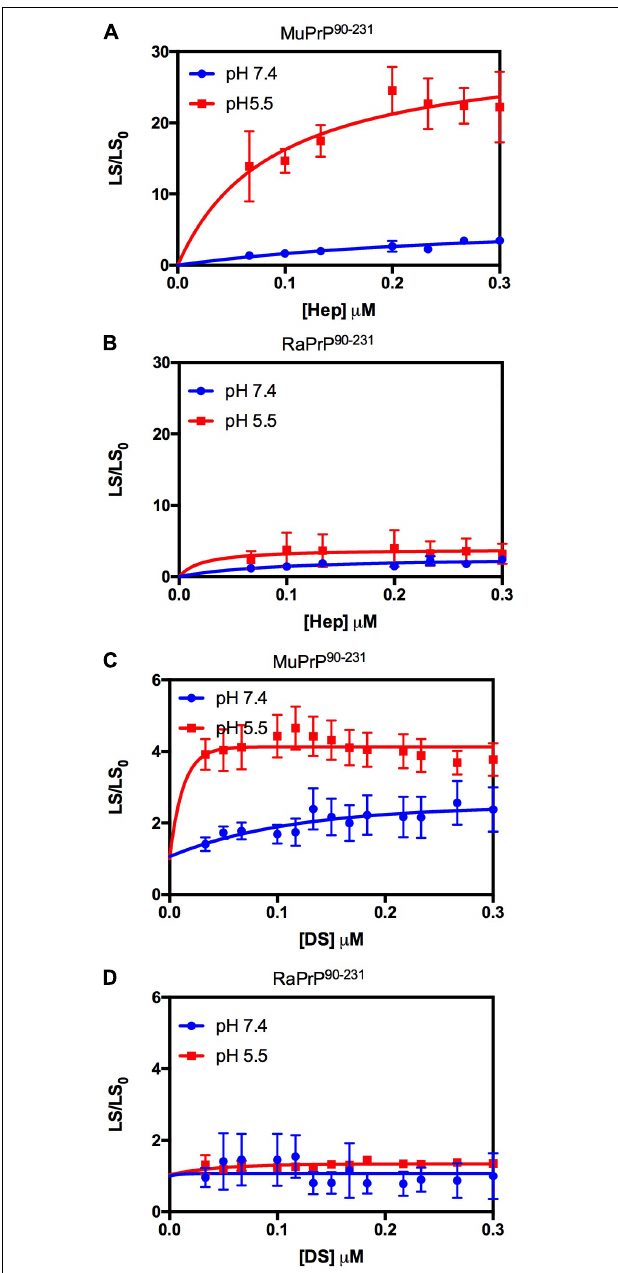
FIGURE 3 | Rabbit PrP 90 − 231 aggregates less in the presence of GAGs. Effect of increasing concentrations of Hep (A,B) and DS (C,D) on the aggregation of MuPrP 90 − 231 (2 µ M) (A,C) and RaPrP 90 − 231 (2 µ M) (B,D) at pH 5.5 (red) and 7.4 (blue). The experiments were performed in 50 mM Tris buffer containing 100 mM NaCl at pH 7.4 or in 20 mM sodium acetate buffer containing 100 mM NaCl at pH 5.5. All experiments were performed at 25 ◦ C. The error bars represent the standard deviation of at least two independent